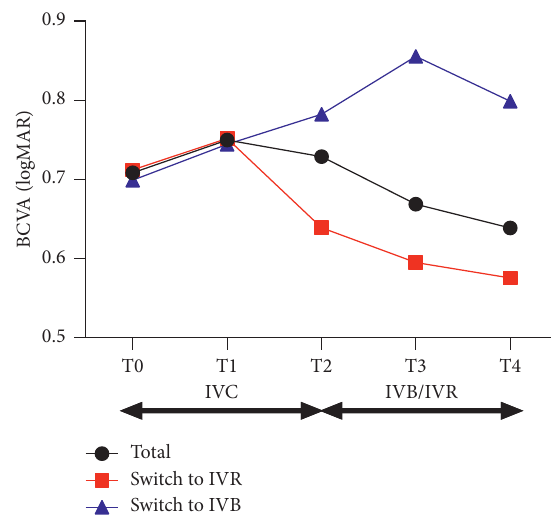
Figure 1: Changes of mean BCVA in eyes with persistent nAMD. There was no significant improvement of BCVA during the treatment of conbercept. After switching to IVR or IVB, BCVA slowly improved from 0.73 ± 0.48 to 0.67 ± 0.41 at T3 ( p � 0 . 0849) and 0.64 ± 0.41 at T4 ( p � 0 . 0132). No significant difference was found between IVR and IVB subgroups for the mean changes of BCVA from T2 to T3 ( p � 0 . 20) and T4 ( p � 0 . 38). BCVA, best- corrected visual acuity; IVC, intravitreal injections of conbercept; IVB, intravitreal injection of bevacizumab; IVR, intravitreal in- jection of ranibizumab; T0, baseline visit; T1, 1 month after the first ICV; T2, 1 month after 3 monthly IVC; T3, 1 month after the first IVR or IVB; T4, 1 month after the last IVR or IVB.